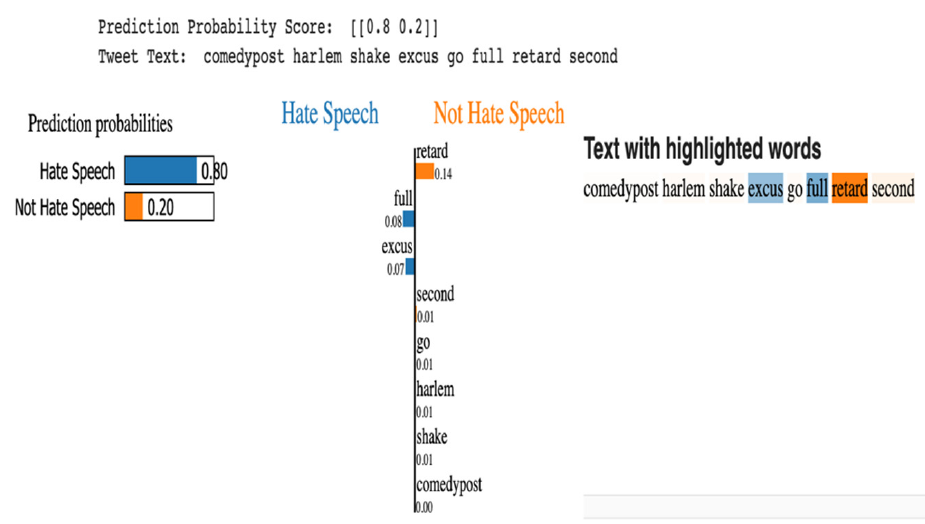
Figure 8. Explainability with Gaussian naïve Bayes.